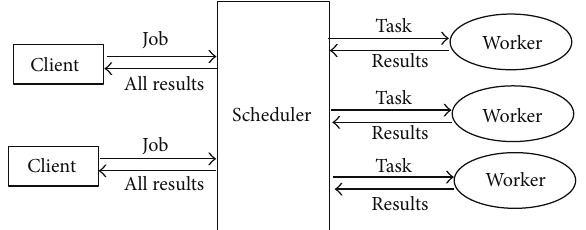
Figure 1: Interactions of Parallel Computing Session.